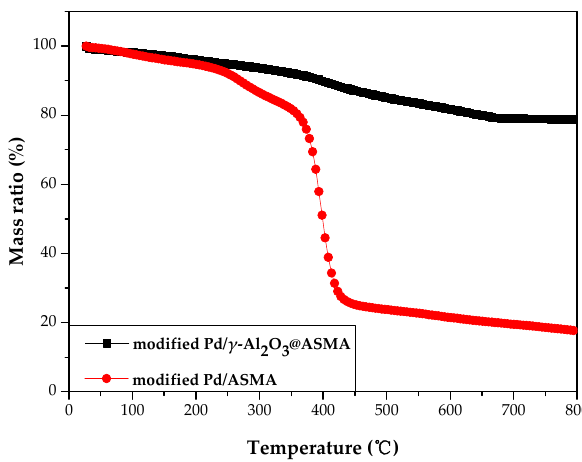
Figure 3. Thermogravimetric analysis (TGA) curves of modified Pd/ γ ‐ Al 2 O 3 @ASMA (black) and modified Pd/ASMA (red). ASMA: amino poly (styrene ‐ co ‐ maleic anhydride).